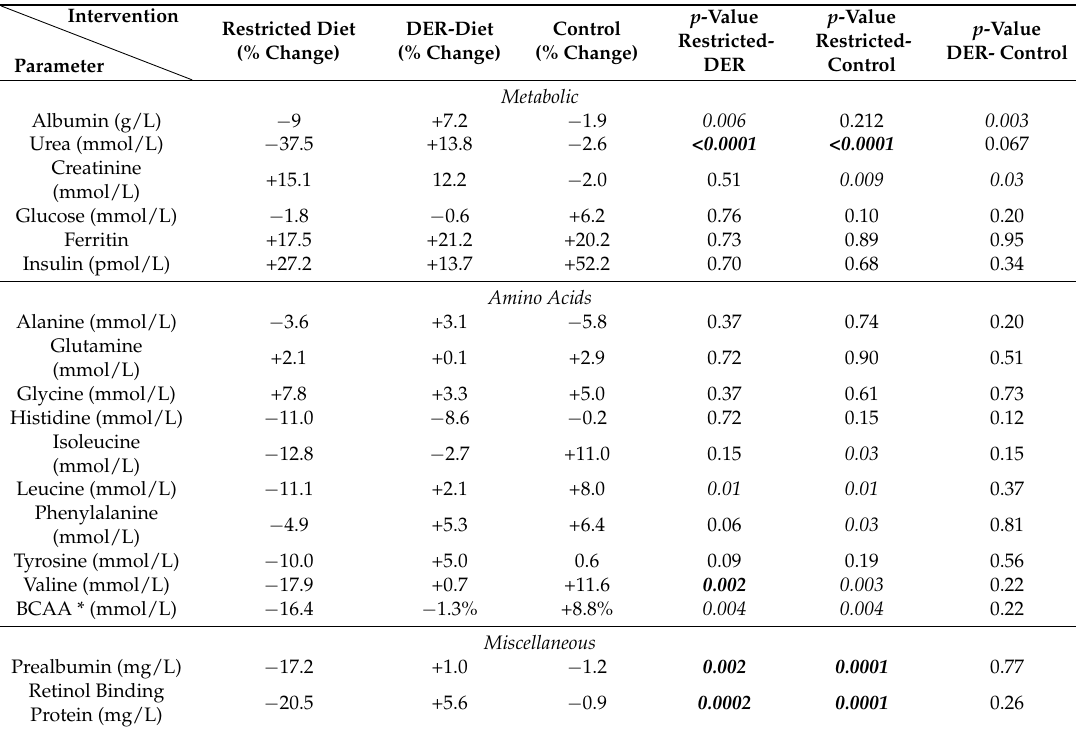
Table 2. Relative changes in metabolic parameters, amino acids and compliance markers after the dietary interventions with their corresponding p -value of intragroup differences.